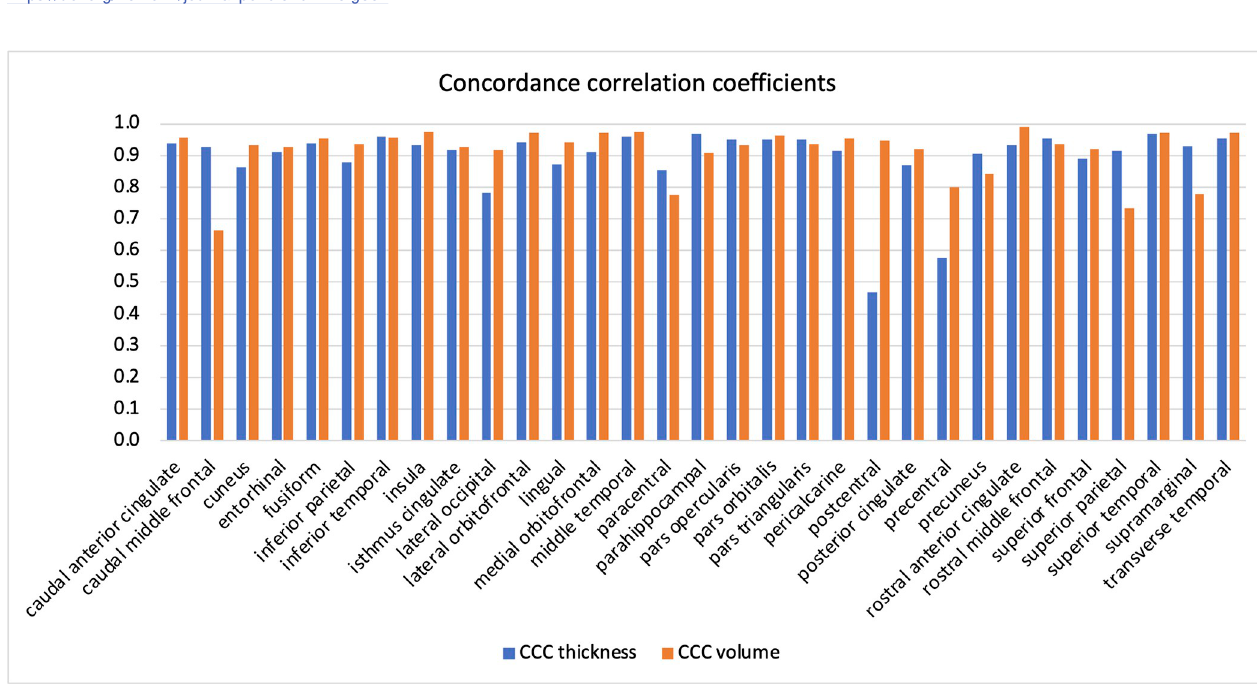
Fig 5. Bar graph displaying the concordance correlation coefficients between DC and nDC data for each cortical ROI.